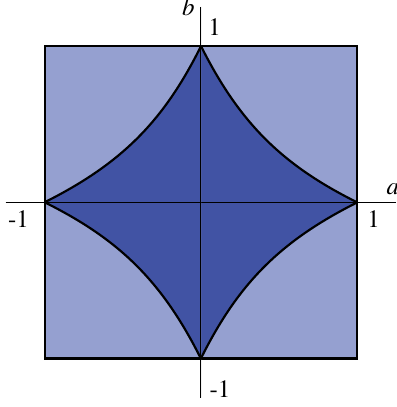
FIG. 3. Phase diagram for the states ρ ð a; b Þ of Eq. (39), with a; b ∈ R . The medium-shaded area shows the physical states; the dark-shaded are shows the states classified as noncontextual by Theorem